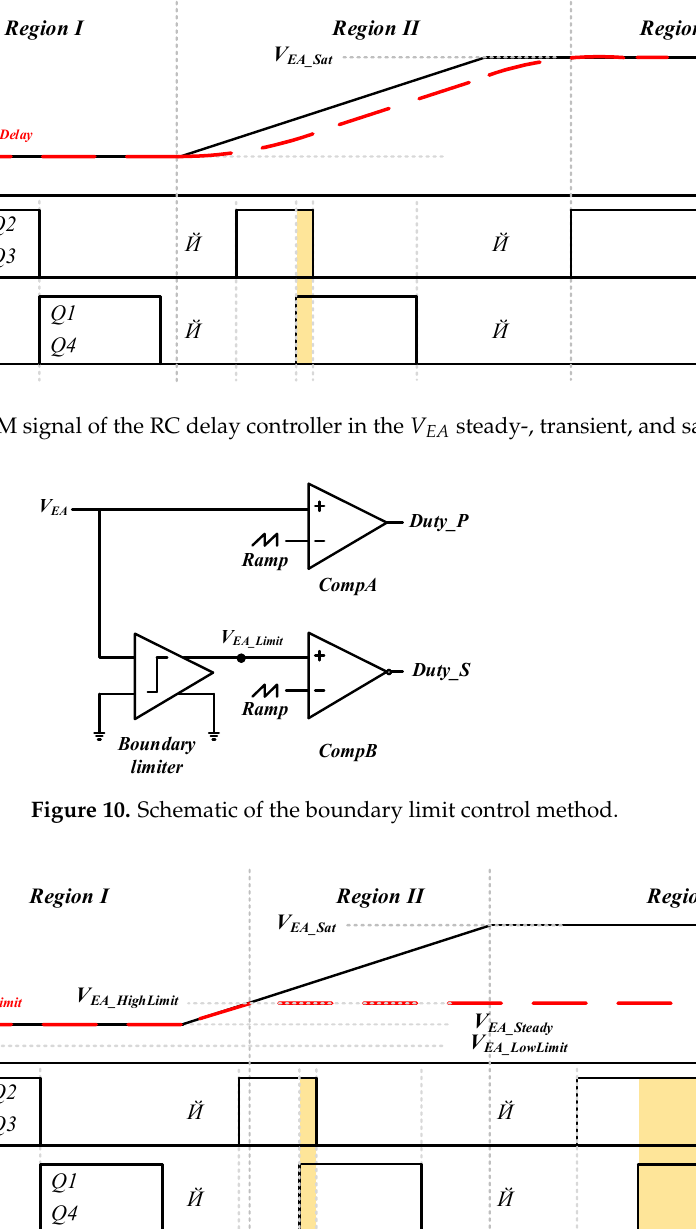
54.17V 46.30V Figure 12. Simulation result of the transient response of the stacked buck converter with the complementary control method.